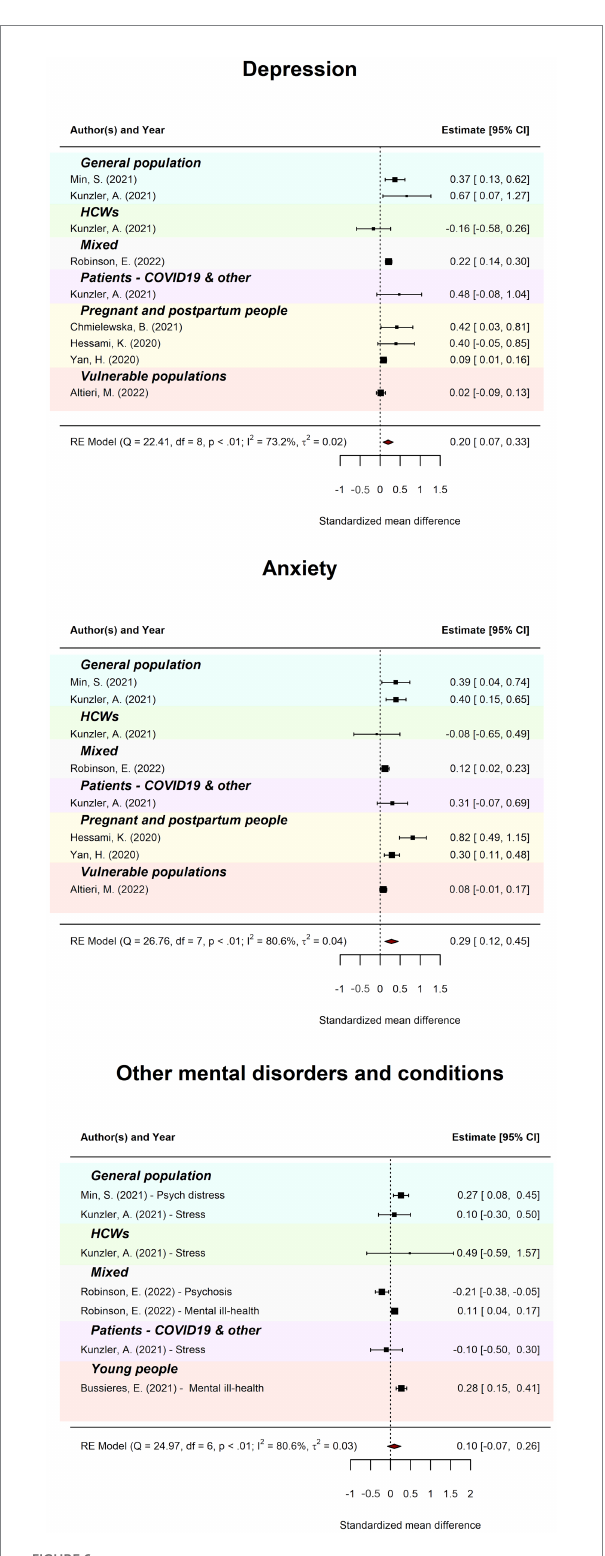
FIGURE 6 Meta-review of pooled standardised mean difference comparing COVID-19 to pre-COVID-19 levels. The forest plots of pooled standardised mean difference (SMD) comparing COVID-19 levels to pre-COVID-19 levels for probable depression, anxiety, and other mental disorders across all subgroups. The 95%CI is indicated by the rightmost, and leftmost points of the